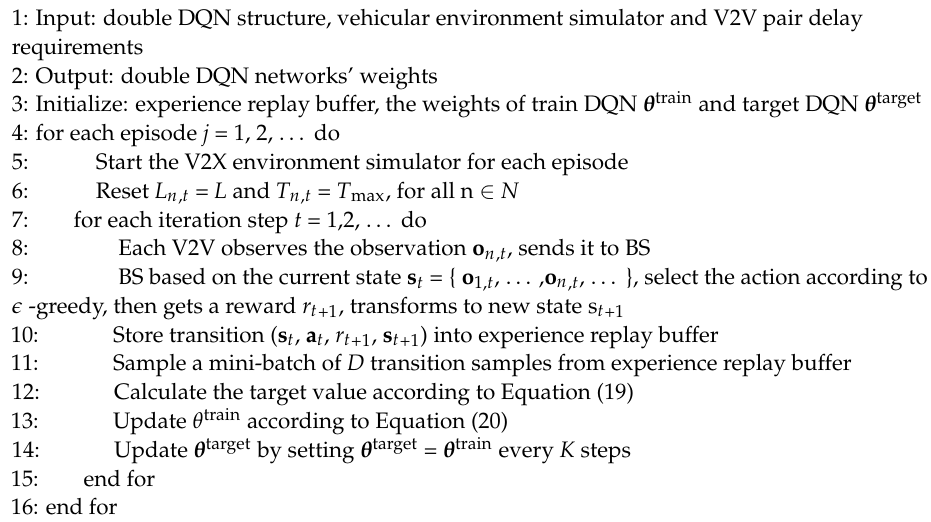
Algorithm 1 Training Process for the Proposed